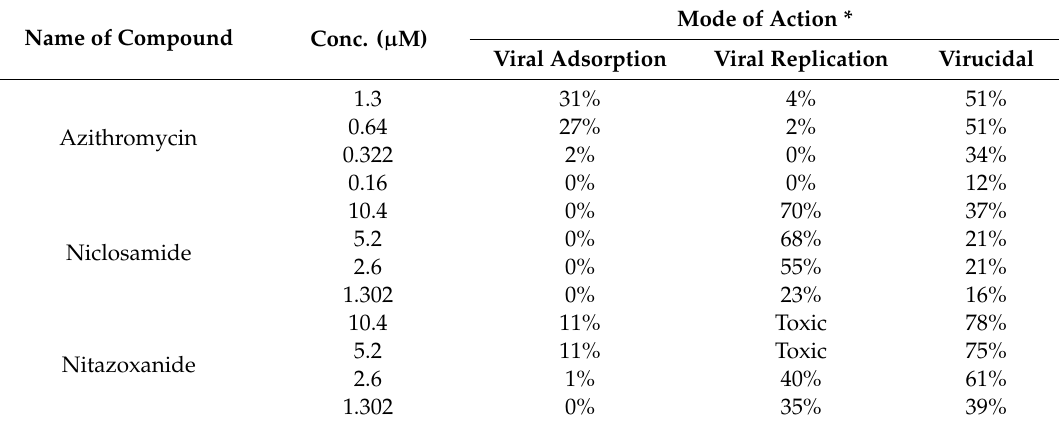
Table 2. Mechanisms of action of FDA-approved anti-microbial drugs with promising antiviral activity for repurposing against